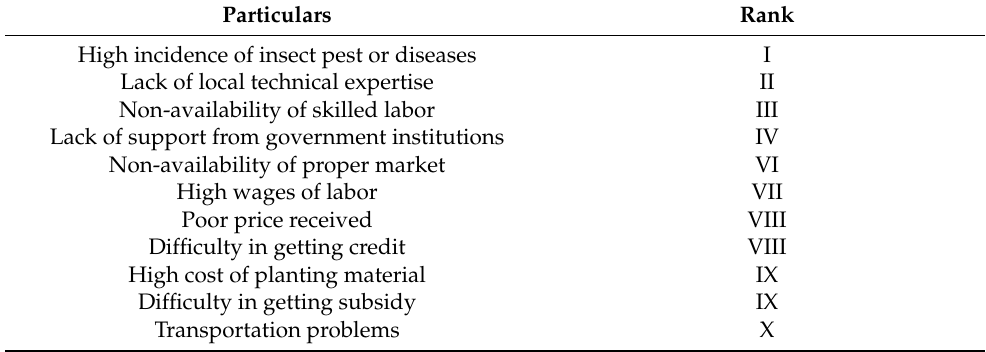
Table 23. Constraints in the adoption of polyhouse cultivation in Dehradun district of Uttaranchal. Particulars